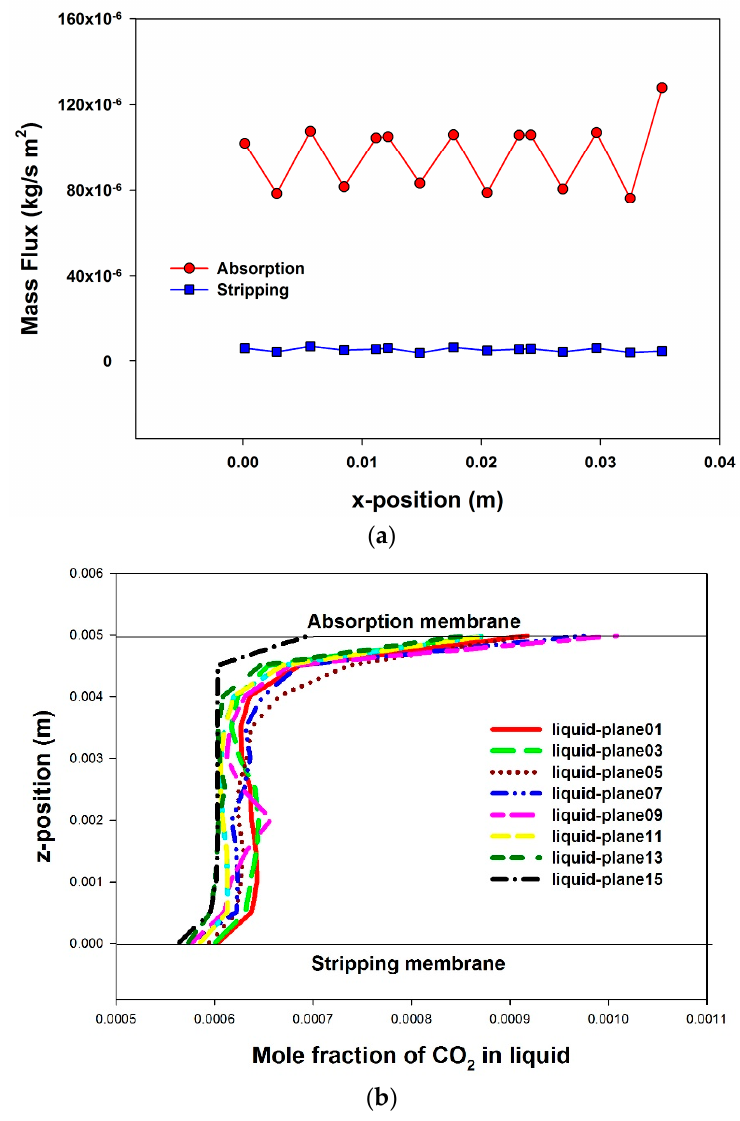
Figure 8. PS-HASMC internal profiles (( a ) transmembrane CO 2 mass flux (BC), ( b ) CO 2 concentration profiles in liquid channel) (Case 1, liquid entrance at liquid-plane-15).